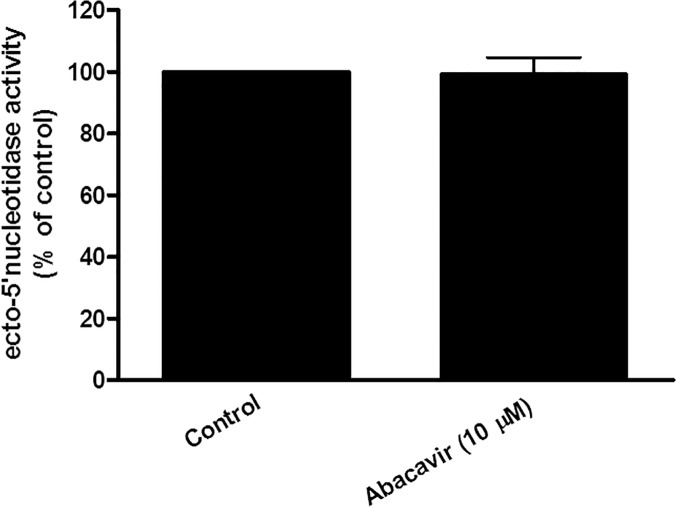
Ecto-5′-nucleotidase activity in HUVECs.HUVECs were treated without (control) or with abacavir (10 μM) for 24 h and the activity of ecto-5’ nucleotidase measured. Values are means ± S.E.M. of three sets of experiments carried out in triplicate and statistical comparisons were made using Student’s t-test.